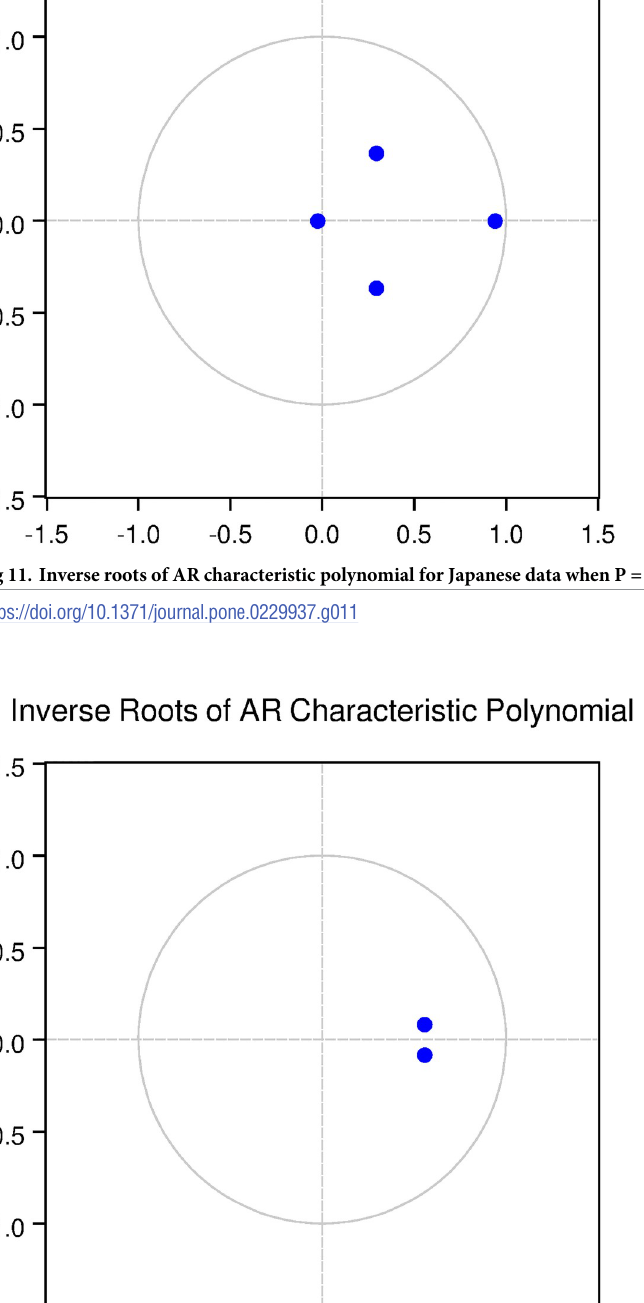
PLOS ONE | https://doi.org/10.1371/journal.pone.0229937 April 2,